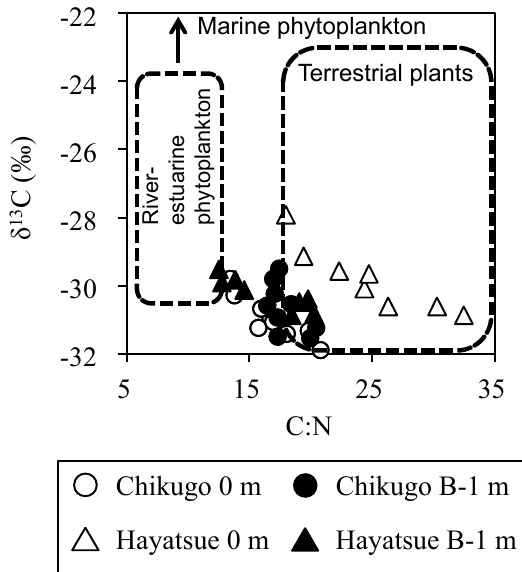
Figure 5. Scatter diagrams of stable carbon isotope ratios ( δ 13 C) against organic carbon-to-nitrogen atomic ratios (C:N). The δ 13 C and C:N ranges for river-estuarine and marine phytoplankton, and for terrestrial plants, are derived from references [26–31].